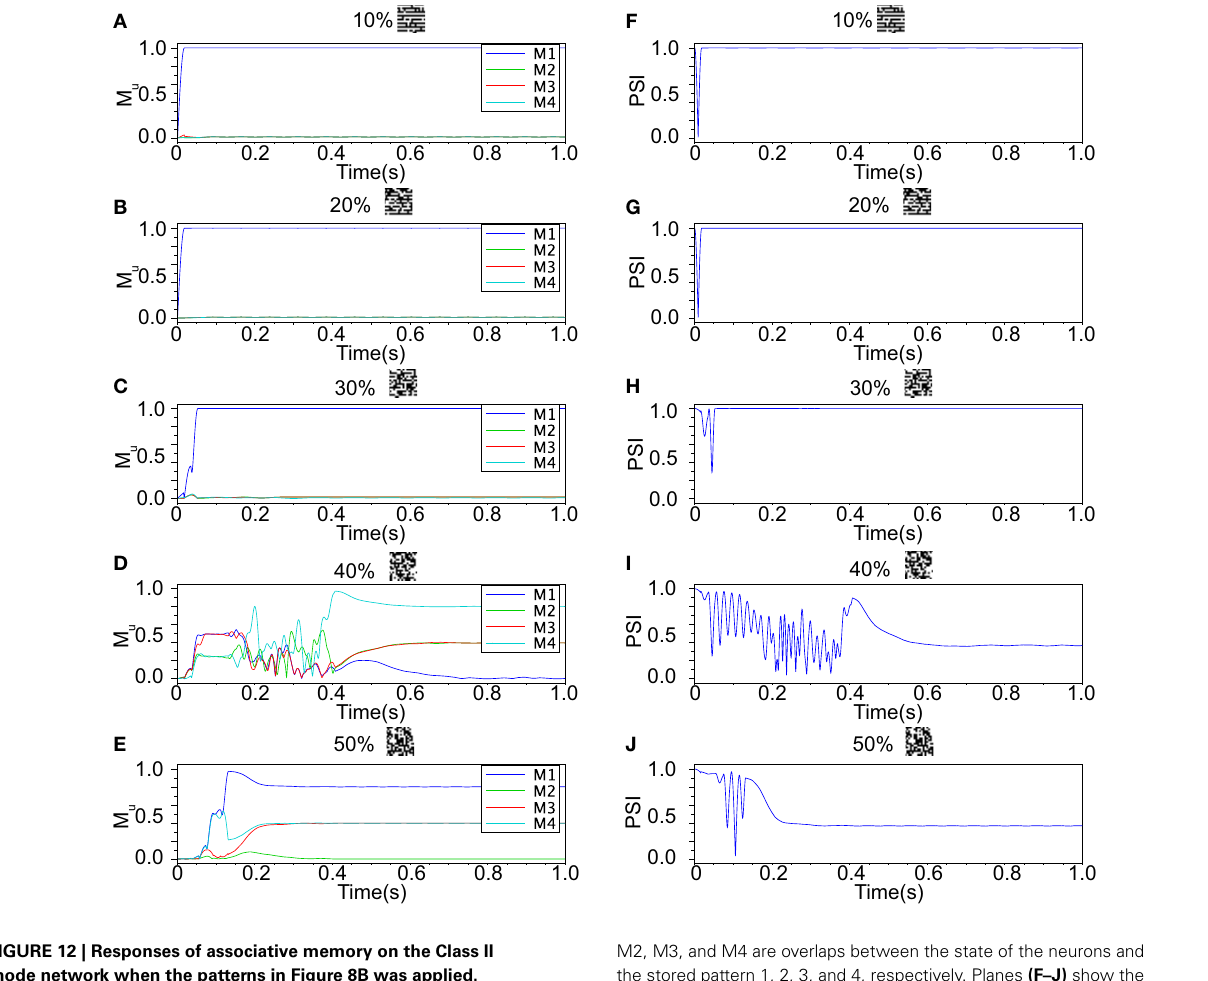
M2, M3, and M4 are overlaps between the state of the neurons and the stored pattern 1, 2, 3, and 4, respectively. Planes (F–J) show the synchronized properties when the input pattern contains from 10 to 50%